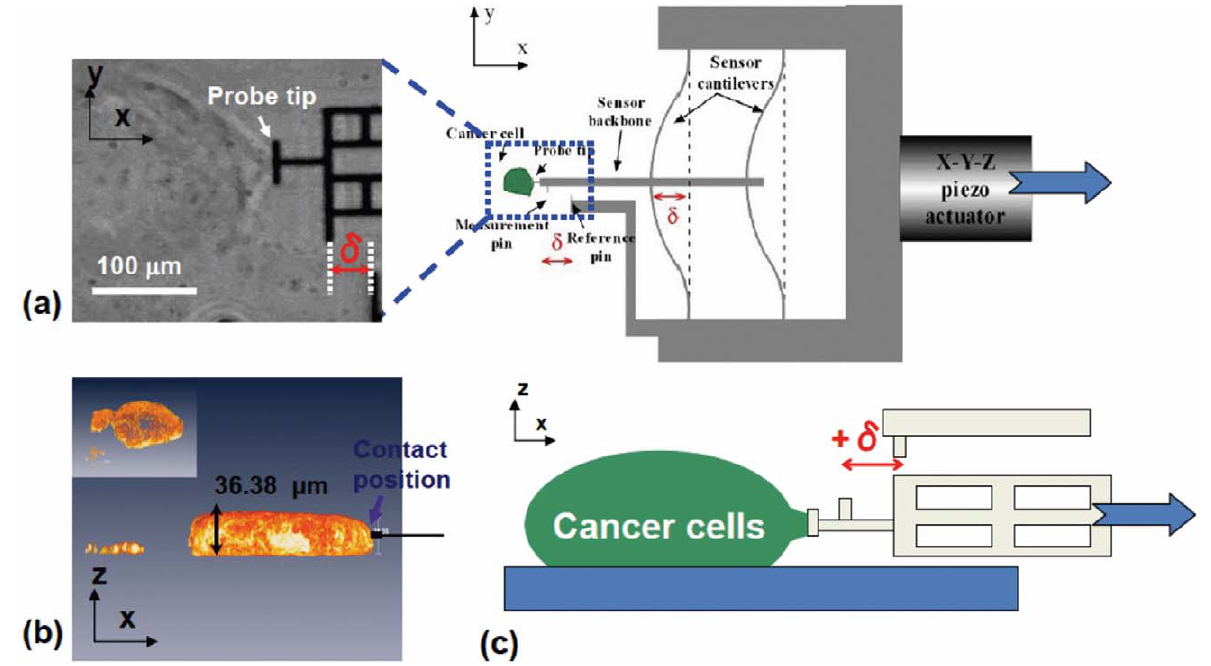
Figure 4. Surface non-specific adhesion of E cell islands measured using a micro-fabricated bio-MEMS force sensor. (a) The non- functionalized micro-fabricated Si force sensor with a flat probe and with known force-deflection relation is manipulated by a high-resolution x-y-z Piezo-stage to contact cell islands’ lateral convex surface (on x-y plane). (b) Confocal microscopy of cell islands show the height of islands is on the order of 30 , 50 m m. The vertical height of bio-MEMS probe is 5 , 10 m m. (c) After a 2-minute contact, force sensor is horizontally pulled away at a constant speed of 2.1 6 0.4 m m/s. While the cell adhesion between the probe and cell surface hinders retraction of the sensor, the sensor beams deform by d , giving the force F. Note that the probe is not functionalized. The 2-minute contact between the probe and cells prevents the activation of cell integrins and the formation of any cell focal adhesion, which takes . 30 minutes to form.